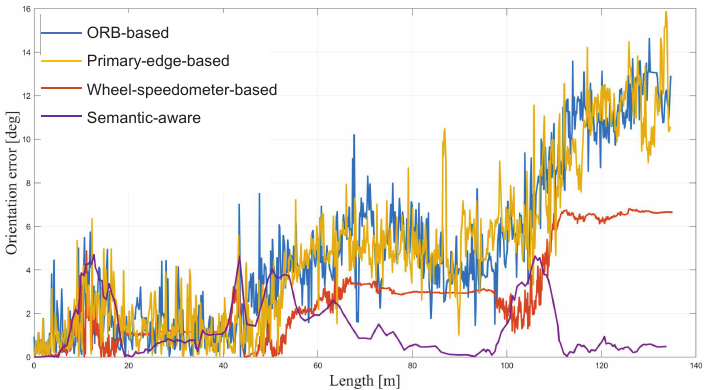
Figure 7. The comparisons of the orientation estimation errors of different methods.